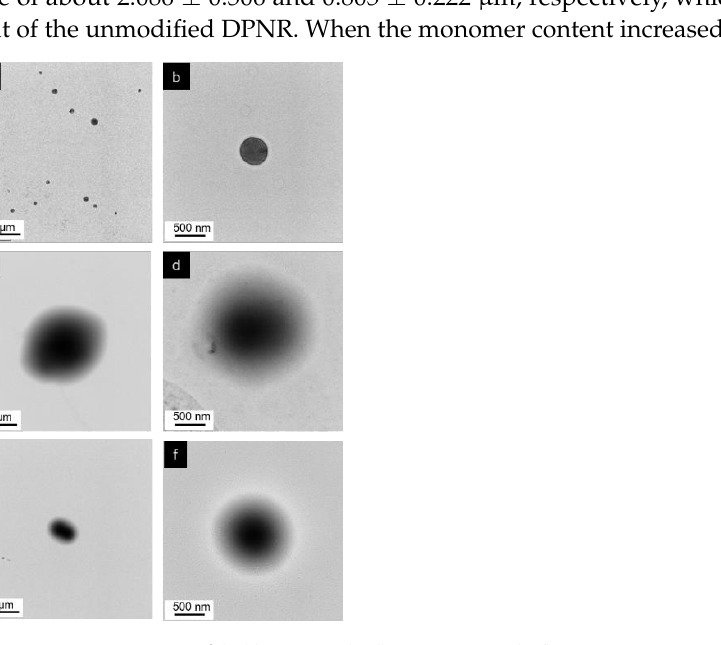
Figure 5. TEM images of ( a , b ) DPNR; ( c , d ) P10-DPNR; ( e , f ) P30-DPNR. Table 3. Particle size, zeta potential, and Tg of DPNR and (PAA- co -PAM)-DPNR with different monomer